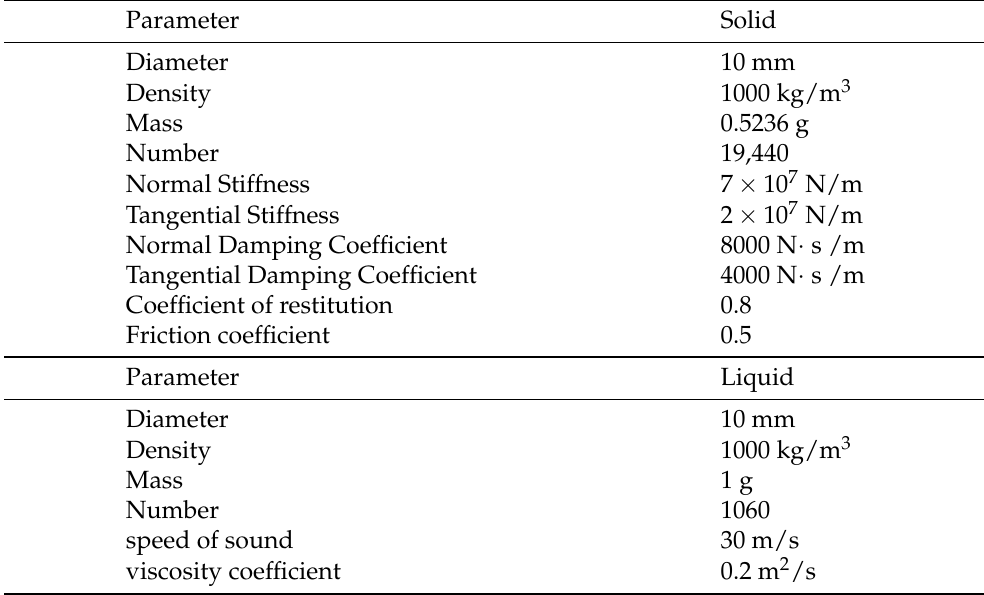
Table 4. Parameters of solid and liquid particles in high shear mixing simulation.